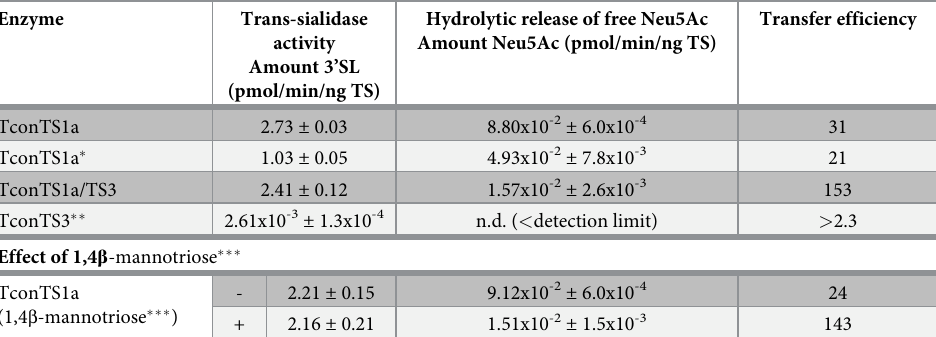
Quantifications of reaction products 3’SL and released free Neu5Ac were done employing HPAEC-PAD analysis as